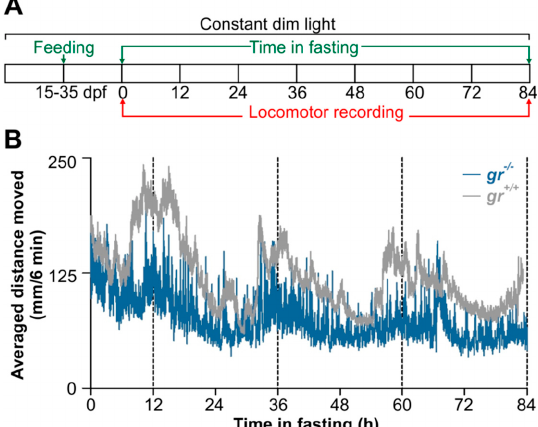
Figure 11. Behavioural entrainment by periodic food availability of gr +/+ and gr − / − zebrafish juvenile. ( A ) Larvae were reared under LL from 15 to 35 dpf and fed once a day at a midday time for 20 days. After then larvae were starved for 84 h and the locomotor activity were recorded. ( B ) Mean waveform of locomotor activity under LL and starvation for 84 h (n = 45/genotype). Vertical dotted lines denote when the feeding would normally have occurred according to the previous regular feeding regime.